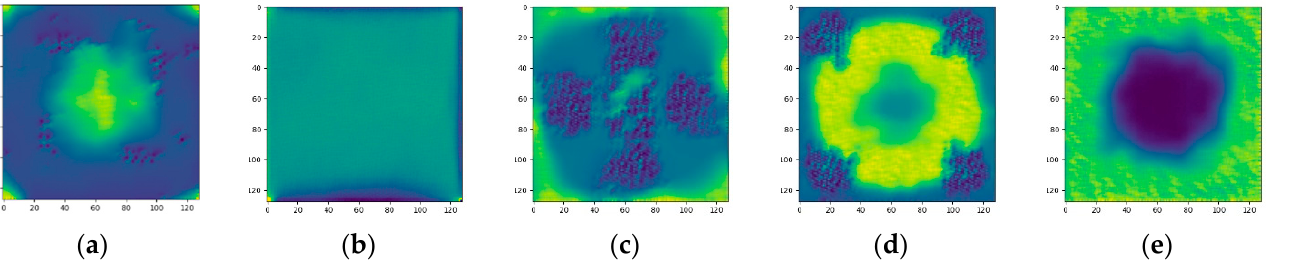
Figure 5. Feature maps of five categories: ( a ) clear night; ( b ) overcast sky; ( c ) light band; ( d ) moon; ( e ) twilight. The brightness of pixels on feature maps represents weights of classification, with brighter color corresponding to higher weight.